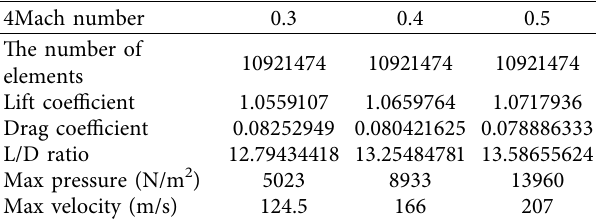
Table 4: Result of NASA SC(2)-0714